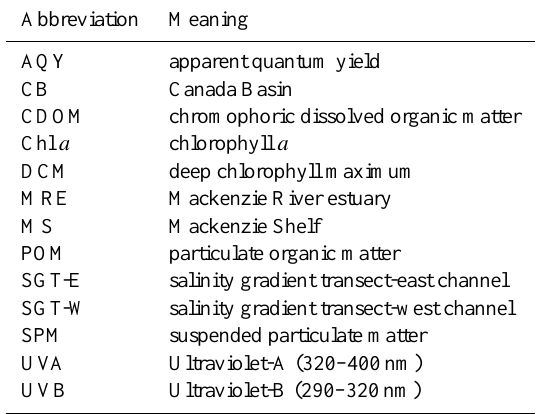
Table A2. List of